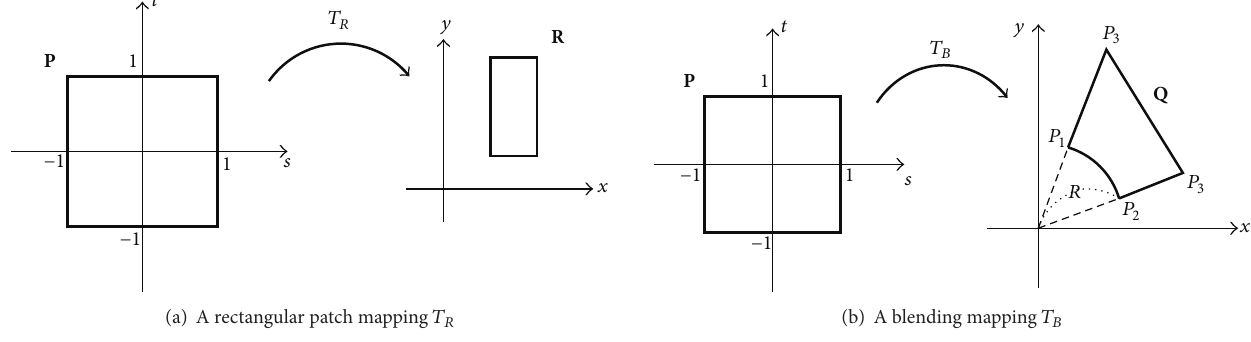
Figure 4: Two patch